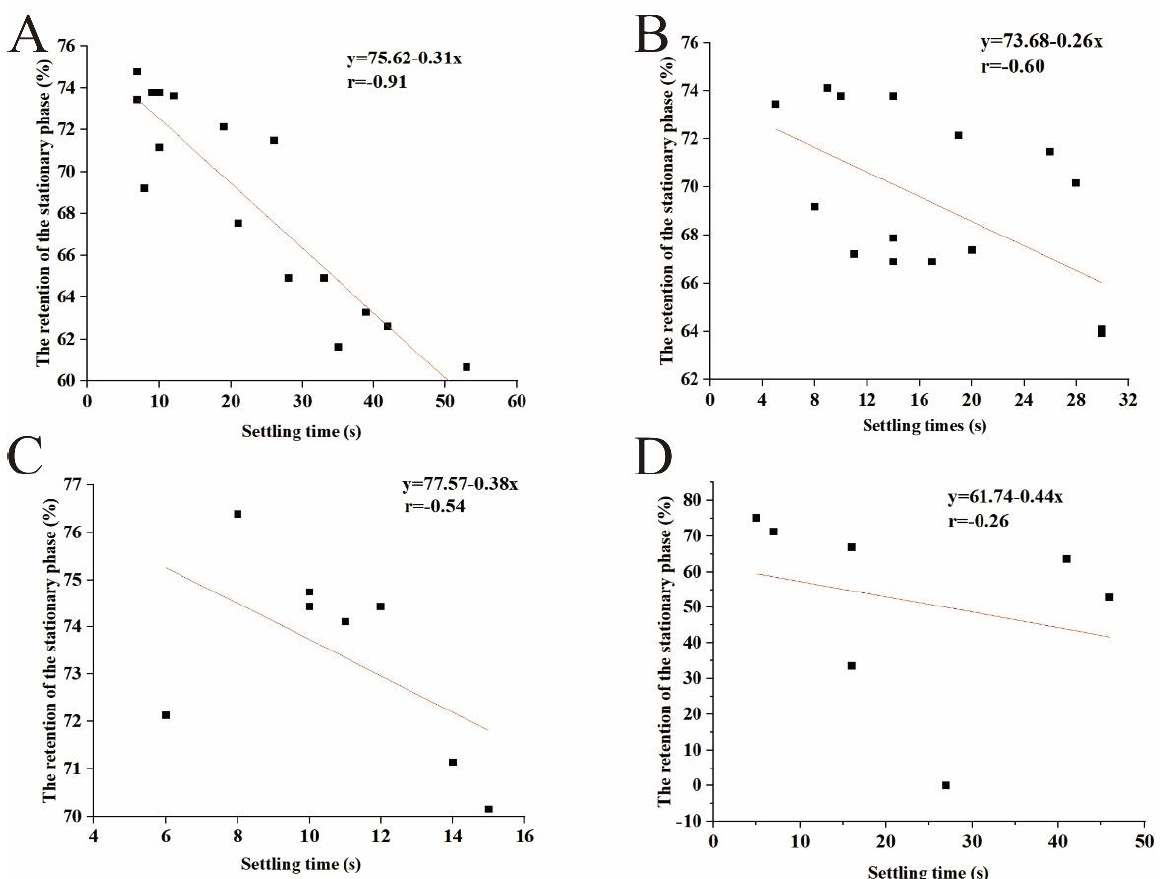
Figure 2. The linear correlation analysis of settling time and the retention of the stationary phase of GUESS − based n -hexane − ethylacetate − methanol − water solvent systems ( A , n = 16), classic n -hexane − ethylacetate − methanol − water solvent systems ( B , n = 16), chloroform − methanol − water solvent systems ( C , n = 8) and n -heptane − n -butanol − acetonitrile − water solvent systems ( D , n = 7).